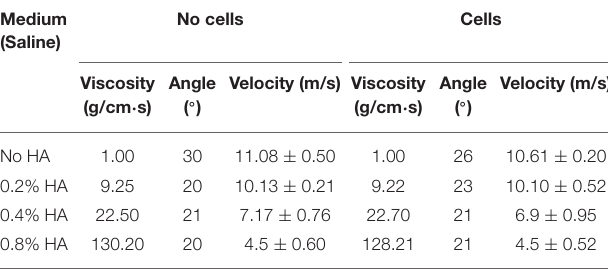
TABLE 1 | Jet outlet velocities and related diffusion angle measurement values. Medium No cells (Saline)